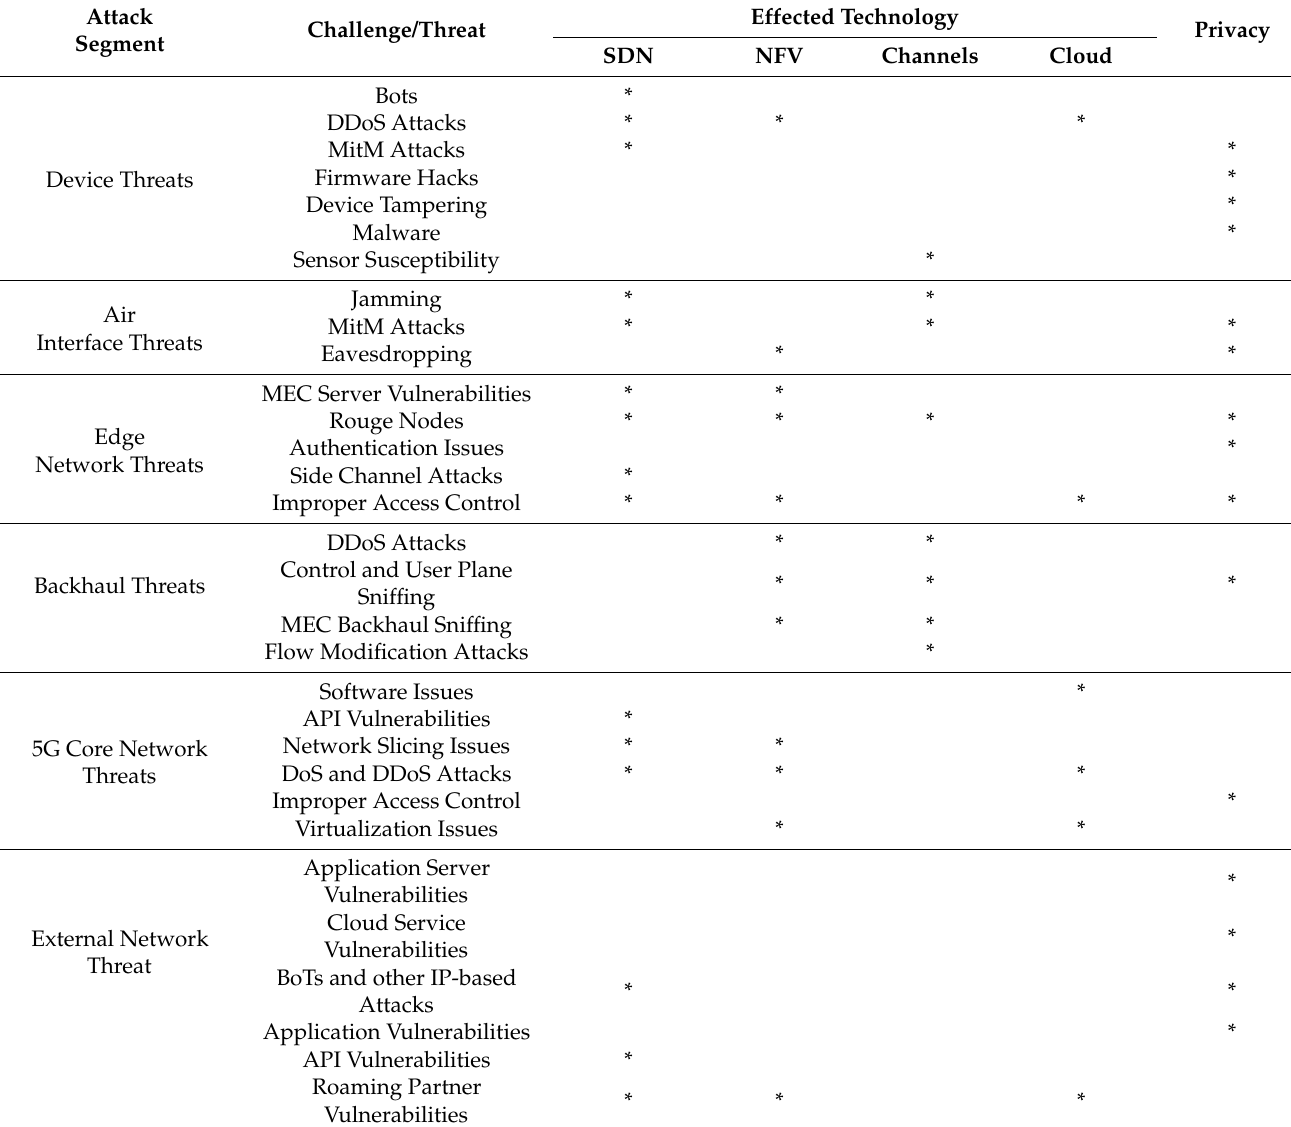
Table 1. Security issues of 5G